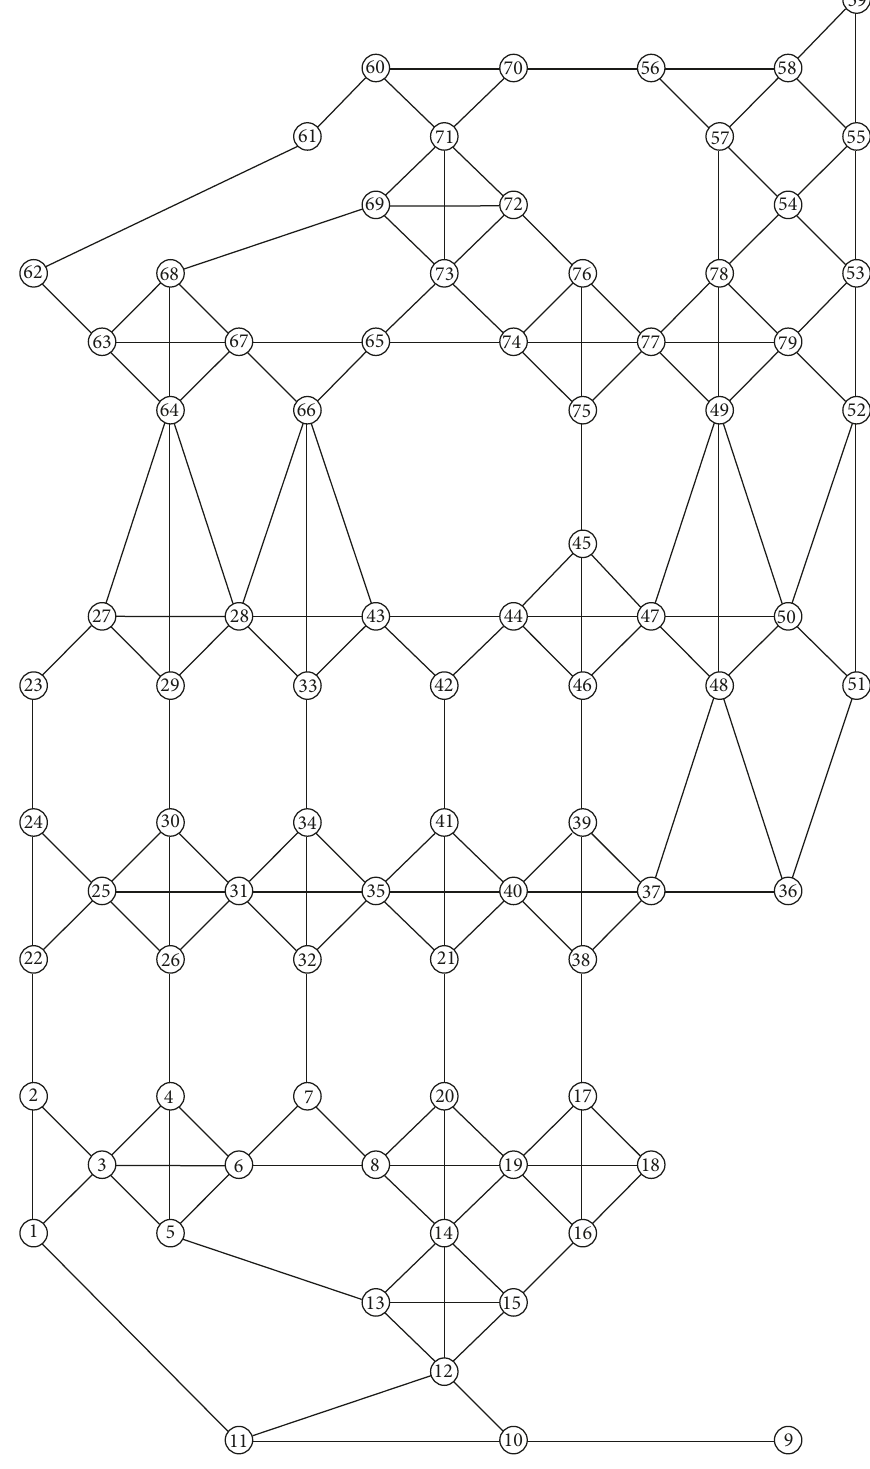
Figure 5: Line graph of the base